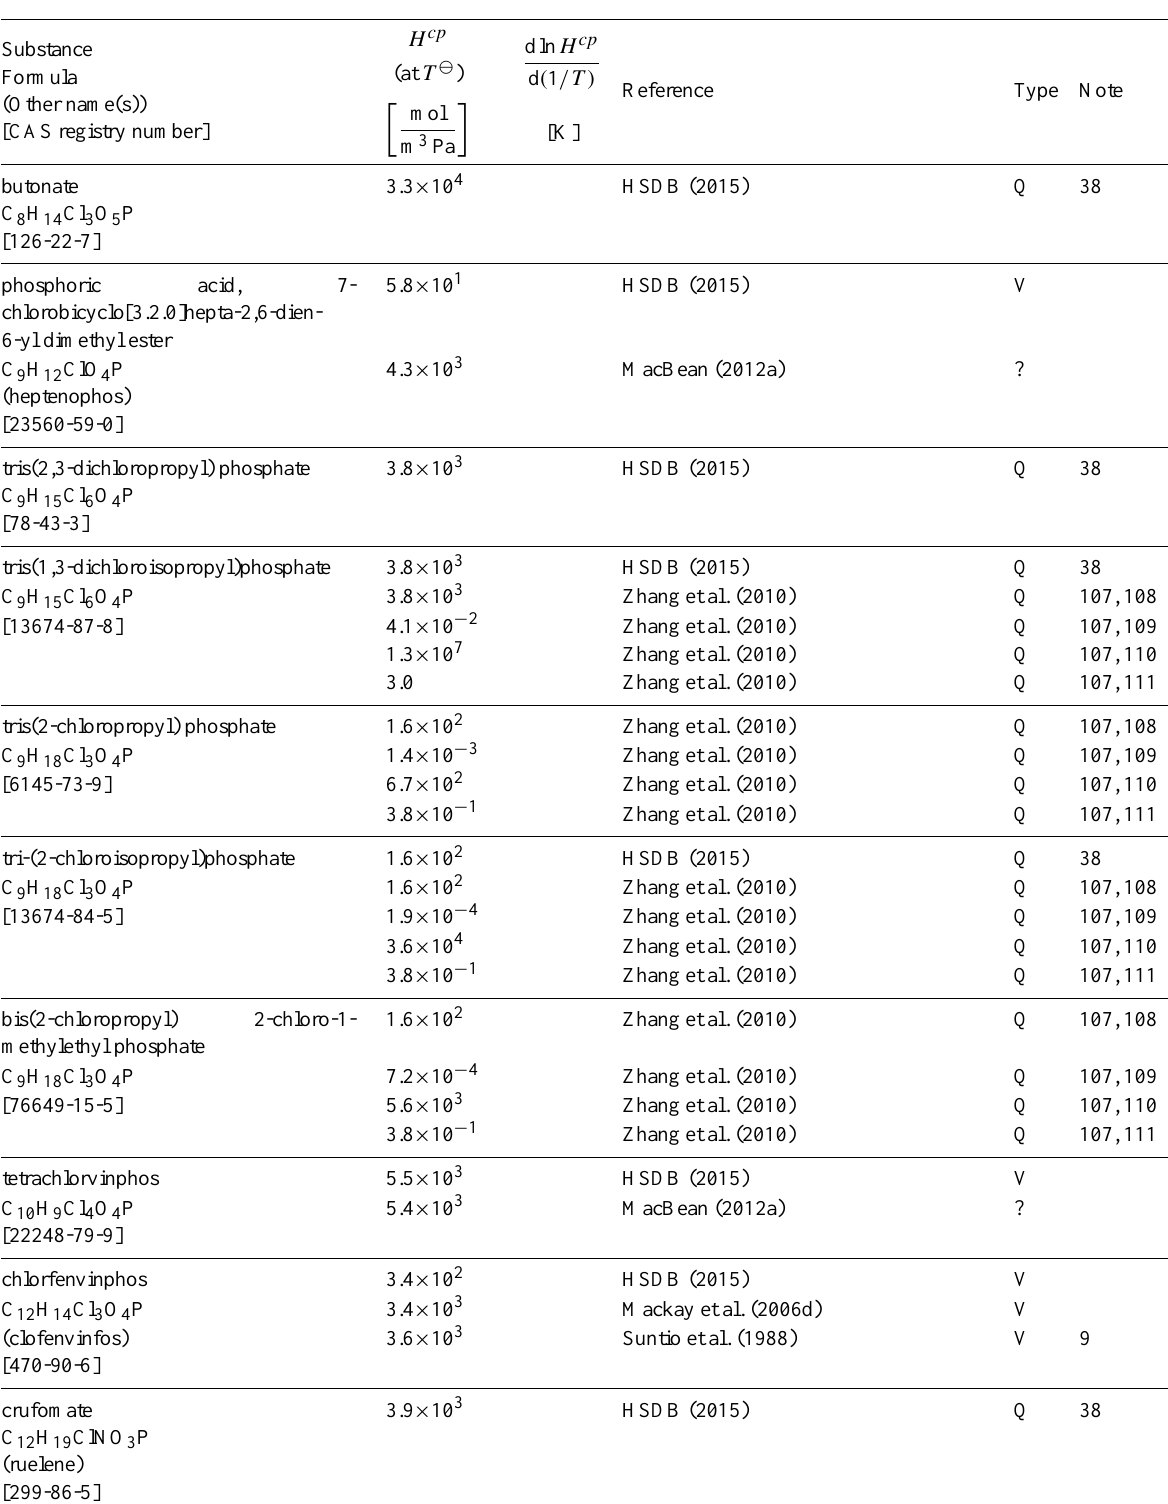
Table 6: Henry’s law constants for water as solvent